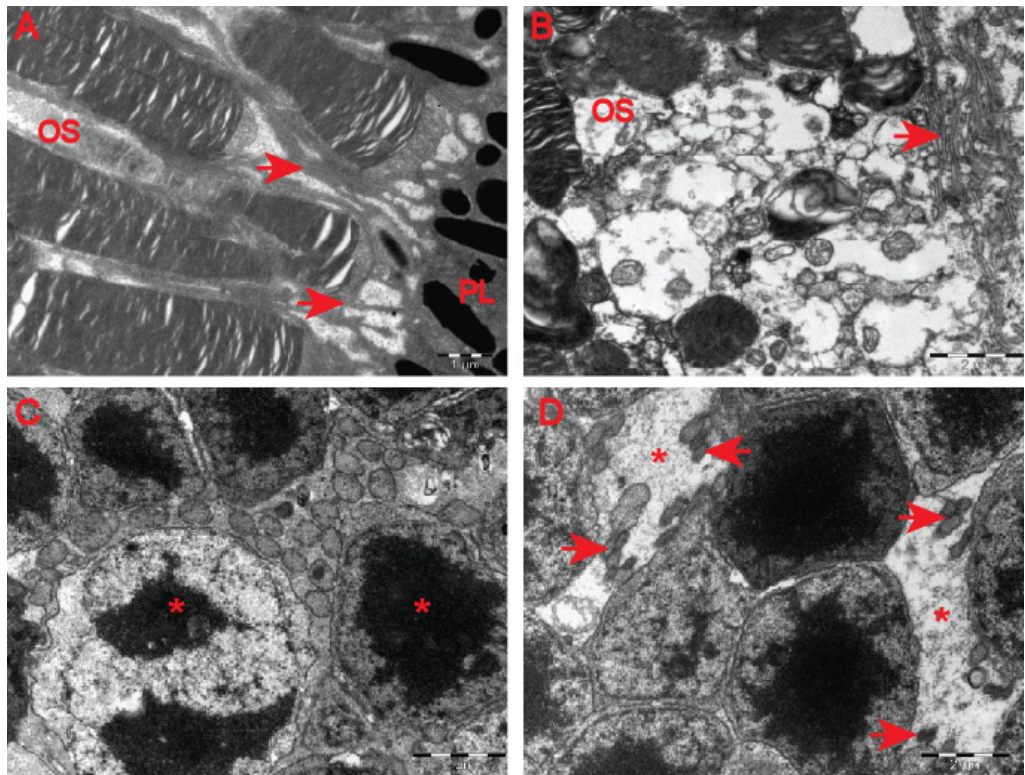
Figure 8. Structural changes in the outer retina of the symptomatic HD mouse model. ( A ) A typical morphology of the microvilli (arrowheads) that arises from the apical membrane of the pigment epithelial cells surrounding outer segments (OS) of photoreceptor cells in wild-type mice. ( B ) An example of degenerative changes within the microvilli (arrowheads) of the apical pigment of the epithelium in the symptomatic HD mouse model. ( C ) A regular structure of photoreceptor nuclei (asterisks) located in the ONL layer of the wild-type mice. ( D ) An example of the ONL (outer nuclear layer) layer structure that displays extracellular empty spaces between nuclei of photoreceptor cells (asterisks). Atrophied axonal projections labelled with arrowheads. ONL—outer nuclear layer.